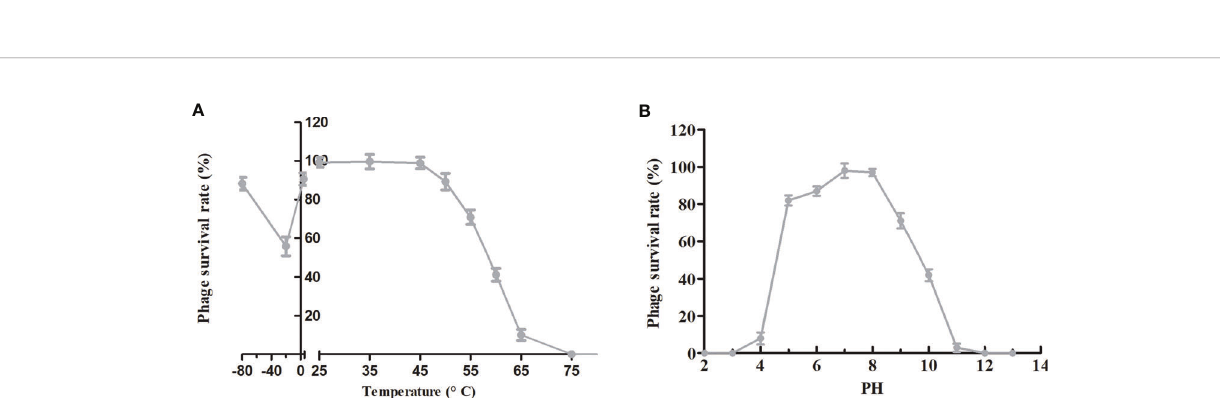
FIGURE 5 | Stability tests of phage PAJD-1. (A) Temperature stability: phage PAJD-1 was incubated at various temperatures as indicated. (B) pH stability: phage PAJD-1 was incubated at different pH conditions for 3 h. Results are shown as means ± SEM from triplicate